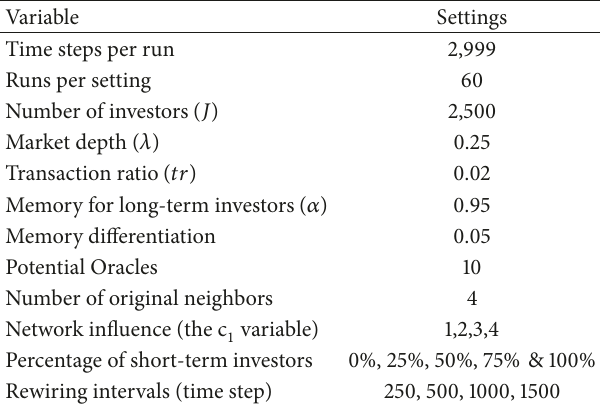
Table 3: Baseline parameter